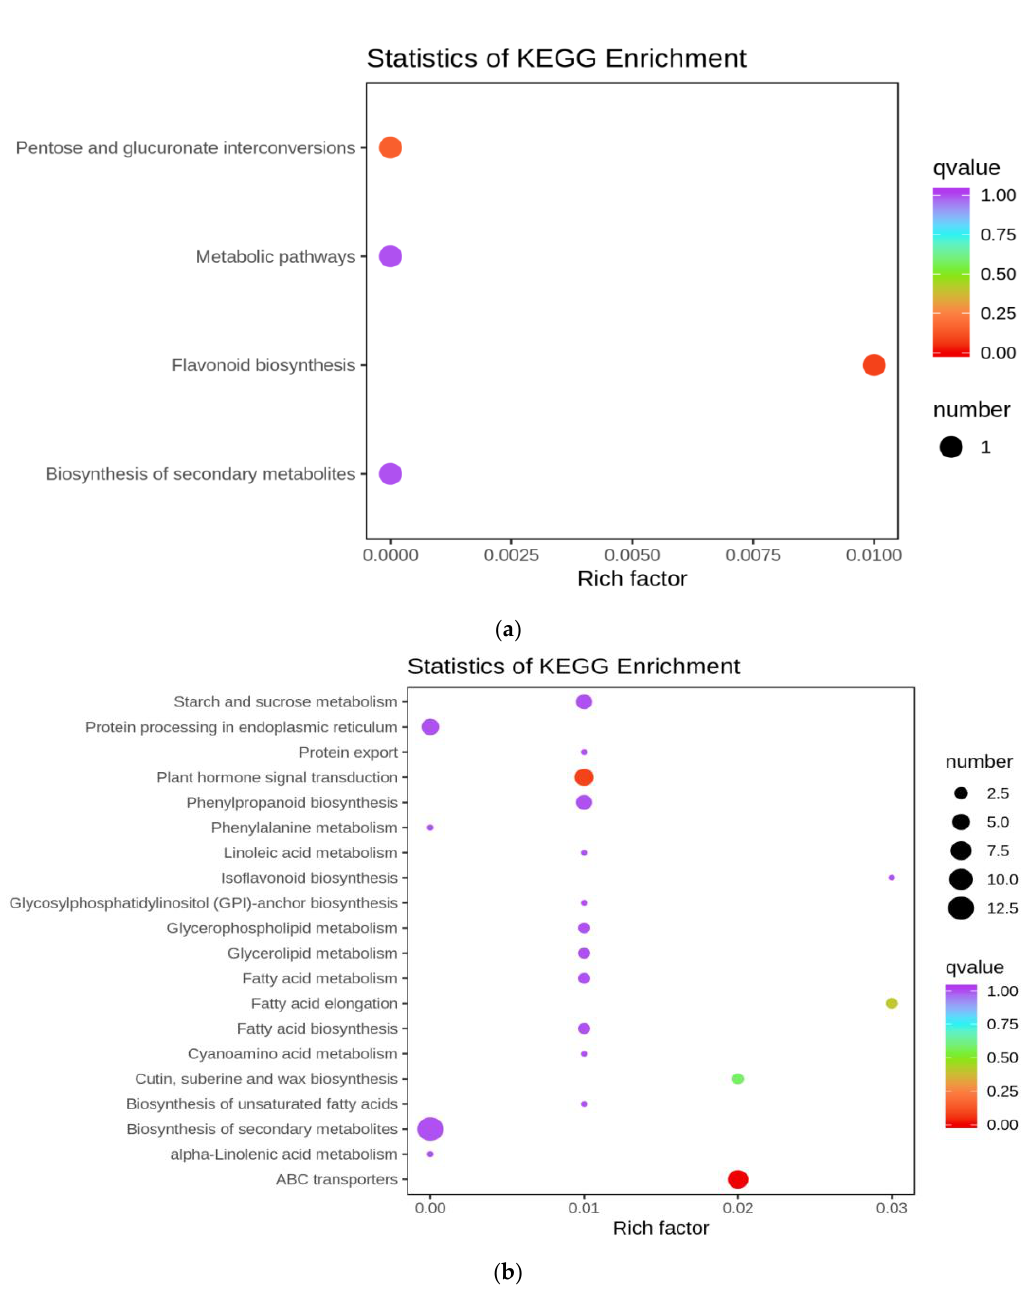
Figure 5. Enrichment statistics of metabolic pathways involving differentially expressed genes: ( a ) KEGG pathway enrichment of DEGs in CK and treatment at 64 days after flowering; ( b ) KEGG pathway enrichment of DEGs in CK and treatment at 71days after